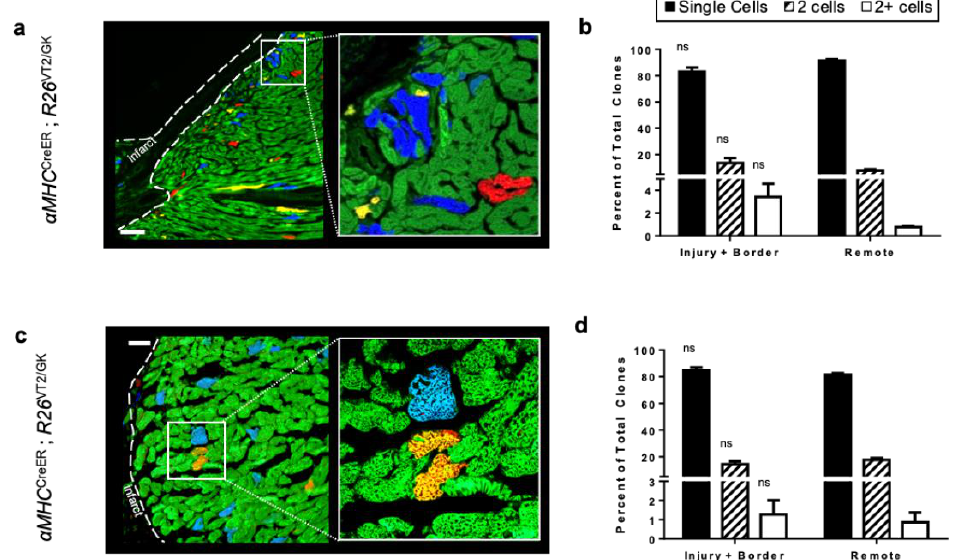
Figure 6. Clonal Expansion in the in vivo diseased heart. Confocal microscope images depicting rainbow-labeled cardiomyocytes in neonatal mouse hearts in response to LAD injury at ( a ) P1 and at ( c ) 8 weeks of age. Analysis was conducted 21 days postinjury [38]; ( b , d ) quantification of cardiac clones following LAD injury. No significant (ns) differences were observed, suggesting that cardio- myocyte generation is due to cardiomyocyte division rather than clonal expansion after injury [38] . cardiovascular research. One major area of interest is using stem/progenitor cell therapies to regenerate damaged myocardium after an ischemic cardiac injury. Due to the low re- generative capacity of adult cardiac tissue, the live cardiomyocytes remaining after a